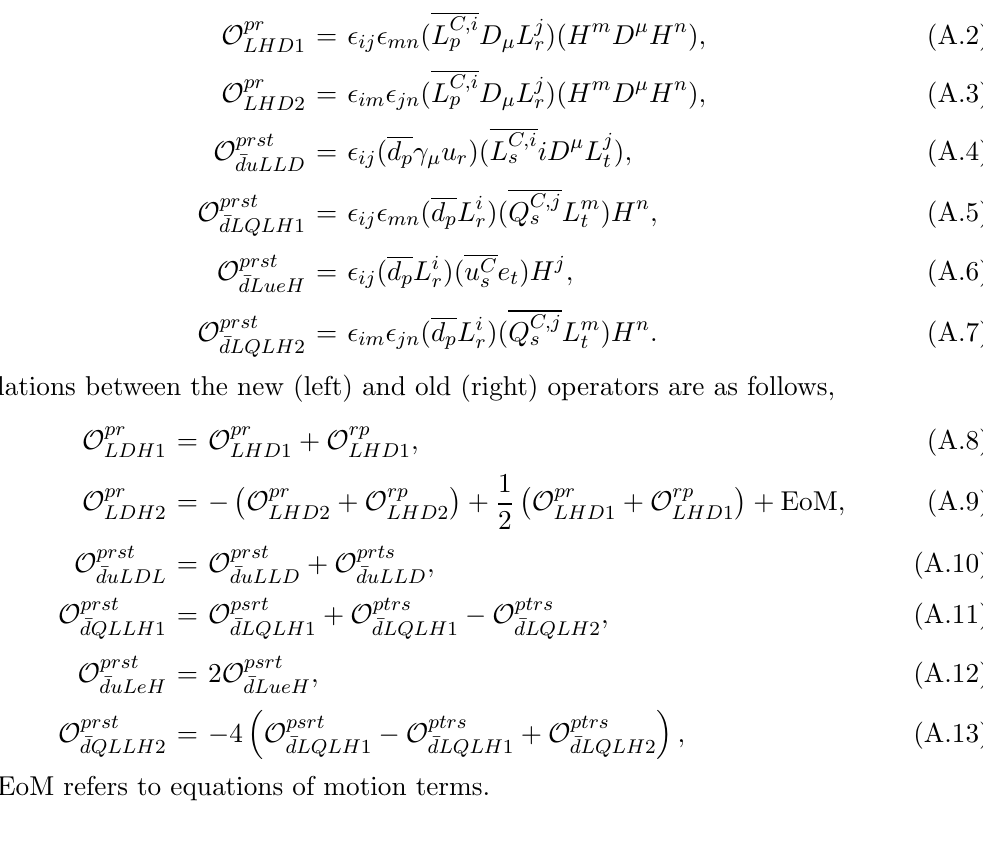
Table 2 . Basis of dim-7 lepton number violating but baryon number conserving operators in SMEFT. L; Q are the SM left-handed lepton and quark doublet (cid:12)elds, u; d; e are the right-handed up-type quark, down-type quark and charged lepton singlet (cid:12)elds, and H denotes the Higgs doublet, respectively. D (cid:22) H n is understood as ( D (cid:22) H ) n . operators [31]: